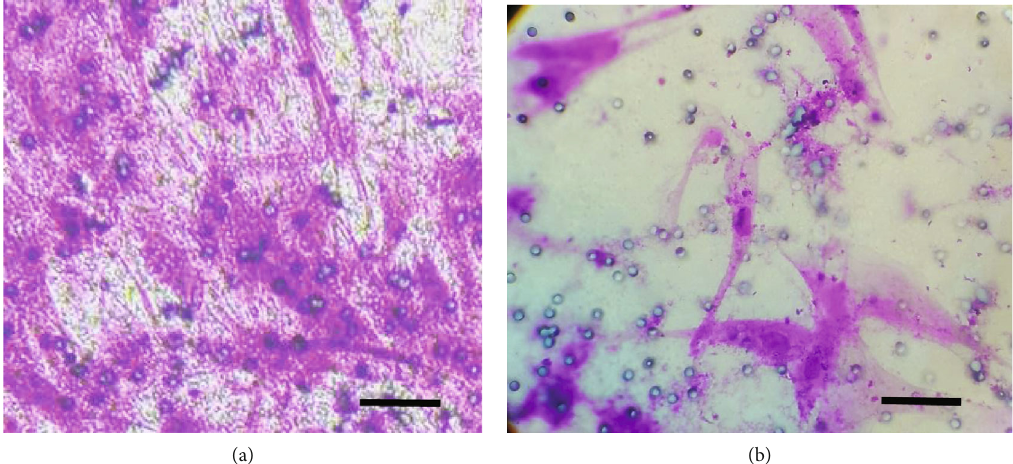
Figure 6: (a) Migrated CD146-positive homogeneous GMSC in the lower compartment of 8 μ m perforated polycarbonate membrane toward fetal bovine serum as a chemoattractant; cells stained with crystal violet; 10,000 cells seeded in the upper compartment. (b) Migrated heterogeneous GMSC in the lower compartment of 8 μ m perforated polycarbonate membrane toward fetal bovine serum as a chemoattractant; cells stained with crystal violet; 10,000 cells seeded in the upper compartment (40x magni fi